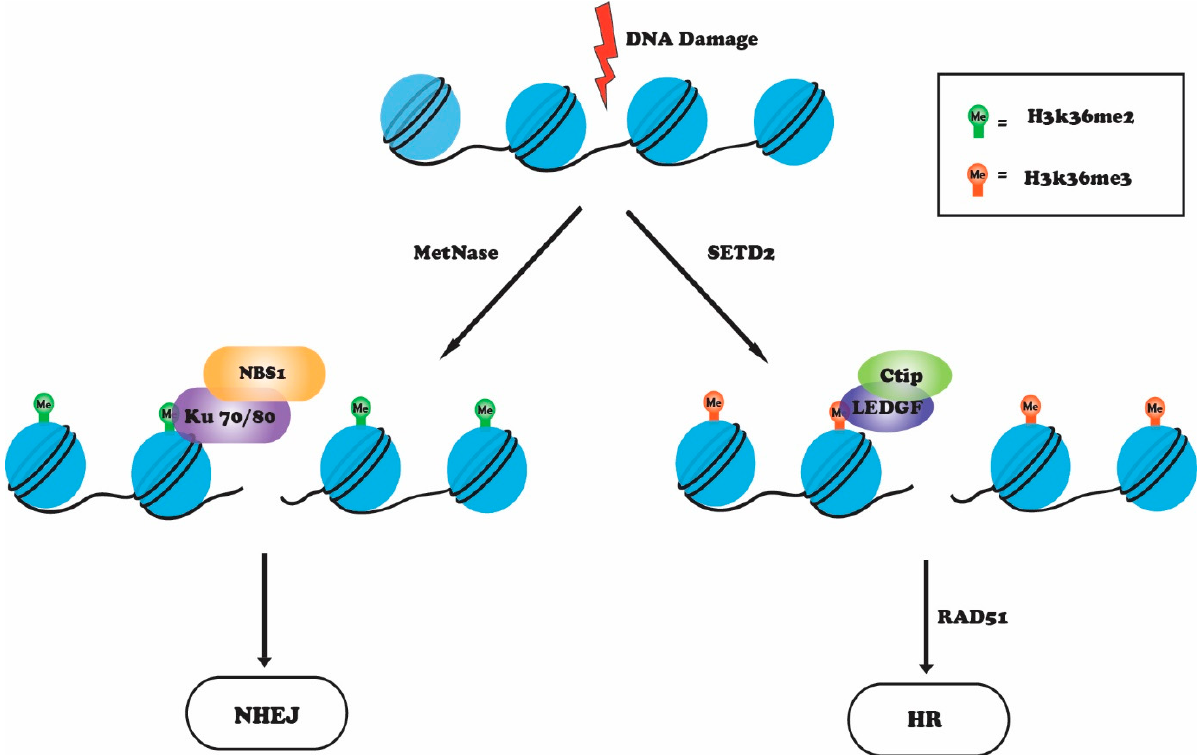
Figure 3. Upon DNA damage, metnase catalyzes H3K36me2, which recruits Ku70-NBS1 complex, to repair DNA damage via NHEJ pathway, whereas H3K36me3 catalyzed by SETD2 favors the HR pathway by recruiting LEDGF-CtIP complex. This is followed by RAD51 recruitment and, in turn, HR repair.